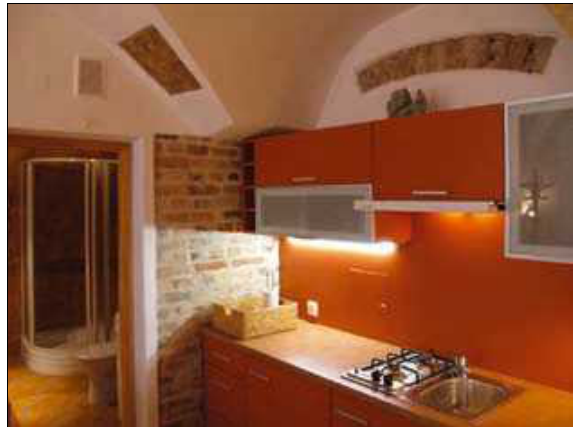
(archit. G. Čaikau­skas, D. Čaikau­skienė) Fig. 5. Interior of a flat in the old